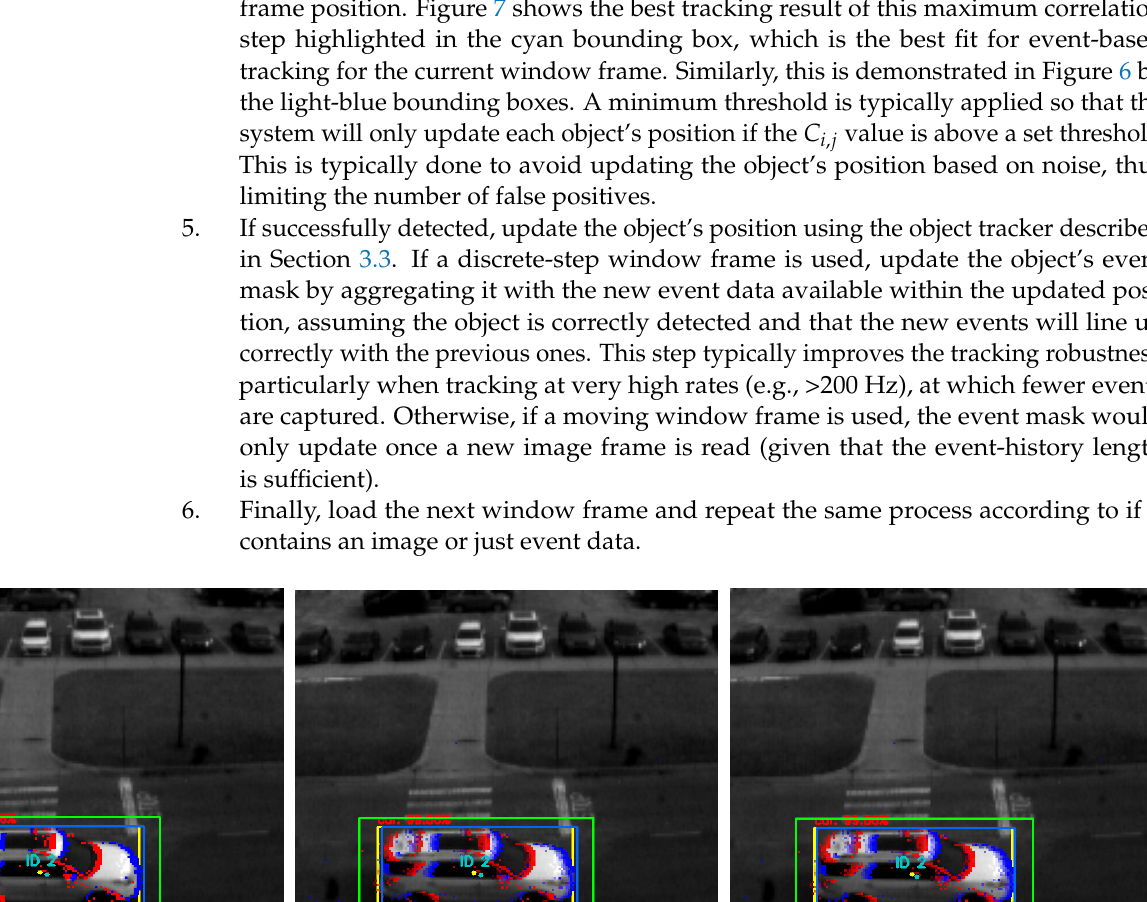
Figure 5. Visualization of ( a ) the actual grayscale image crop based on the bounding box of the detected object; ( b ) event-based mask created from the accumulated events in the current window frame used in event-based tracking; ( c ) a histogram-equalized version of the crop; and ( d ) the gen- erated edge-based mask used for event-based tracking as well.